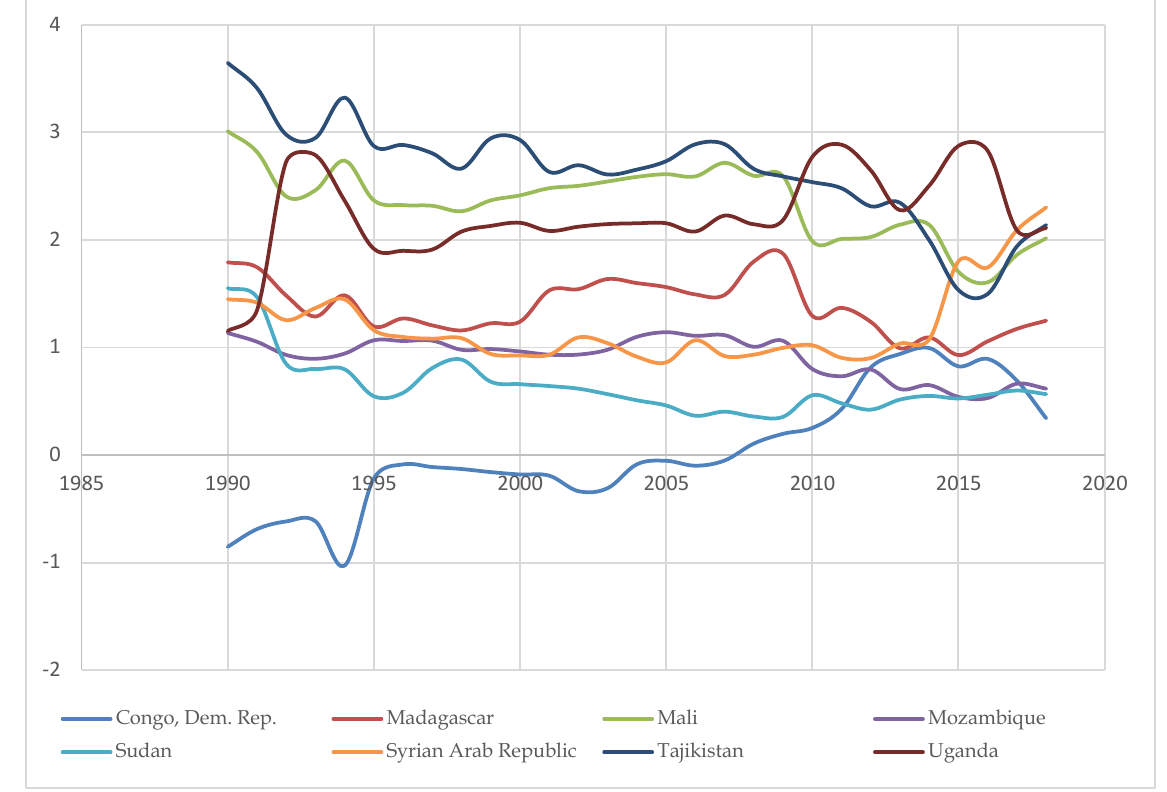
Figure 2. Transportation panel transition paths for Low-income countries (LIC)